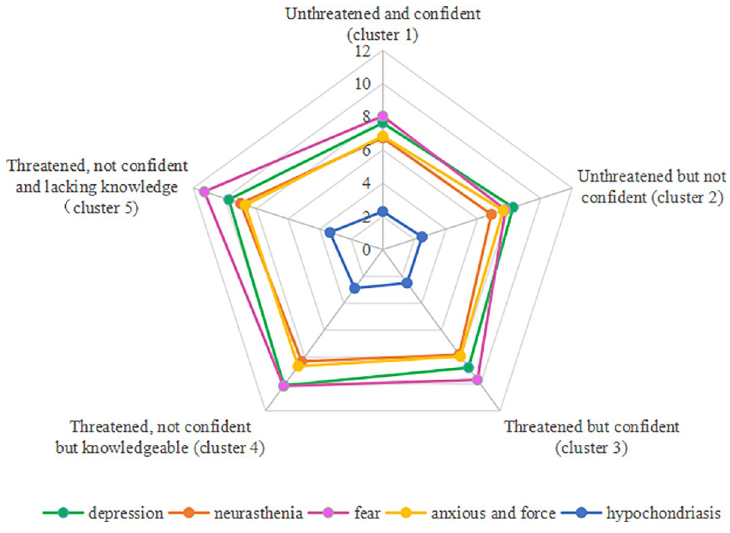
Fig 5. The relationship between threatened perception clusters and mental status.